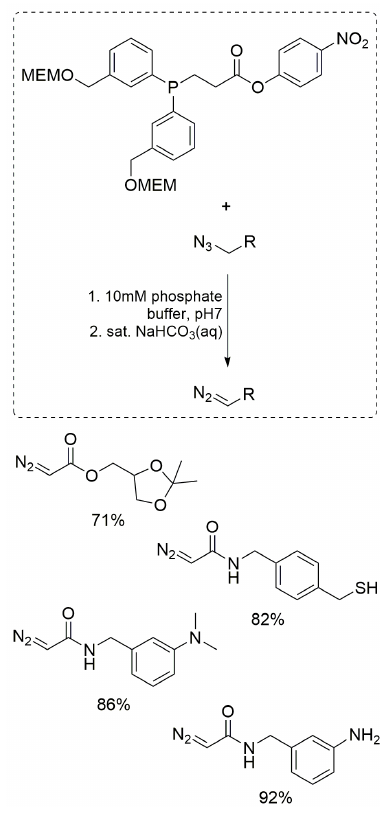
Figure 44 - Development of diazo compounds in water mediated by the developed phosphine.